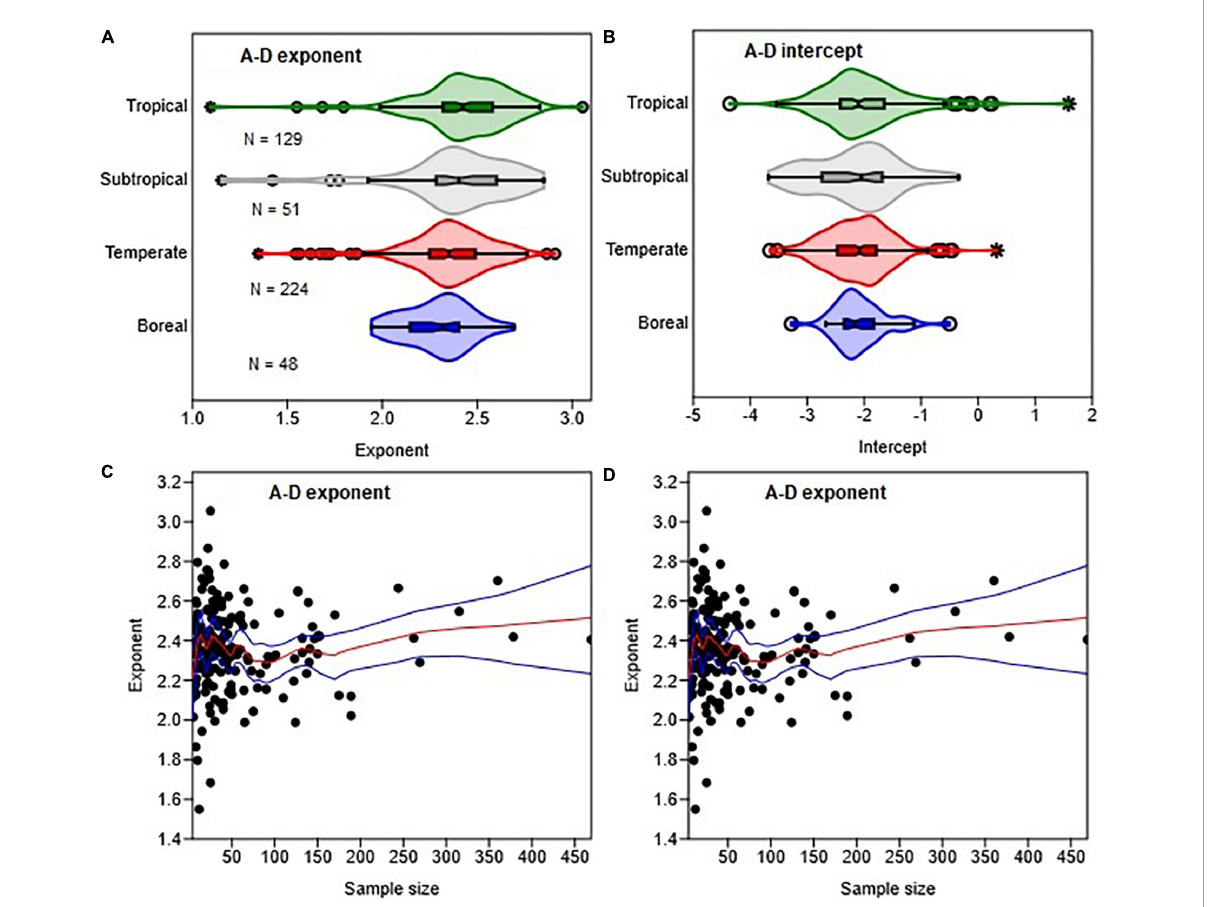
FIGURE5 Variations in the distributions of the A-D allometric exponent (A) and intercept (B) with climate zones and sample size (C,D) . The box and whisker plots display the median and its 95% CI (notches), lower quartile, upper quartile, extreme values, and outliers (O and *). The medians of two or more distributions are not significantly different if the 95% CIs overlap. In (D) the red and blue lines represent the LOESS trends and their 95% confidence bands.